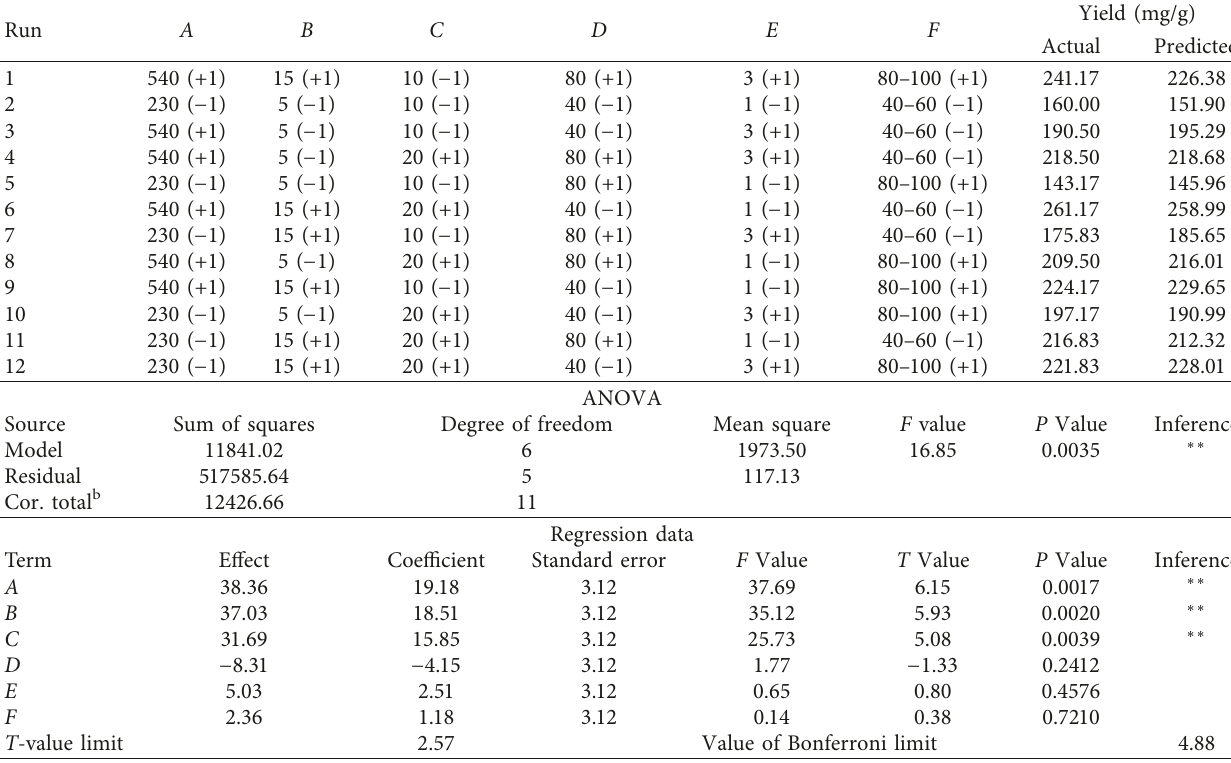
Table 1: Yields of saponins, ANOVA results, and regression analysis of the Plackett–Buran design data for the prediction of significant extraction variables.